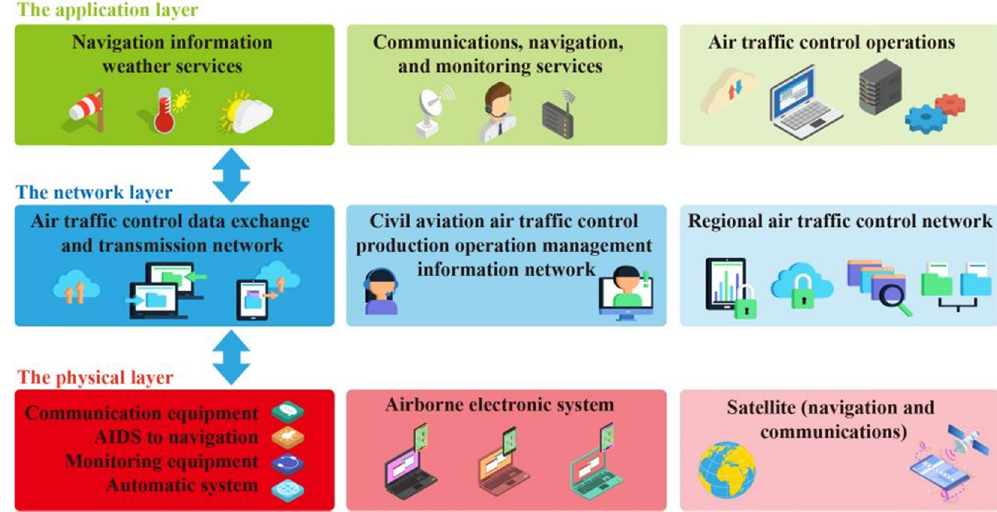
Figure 1: The layer structure of a computer